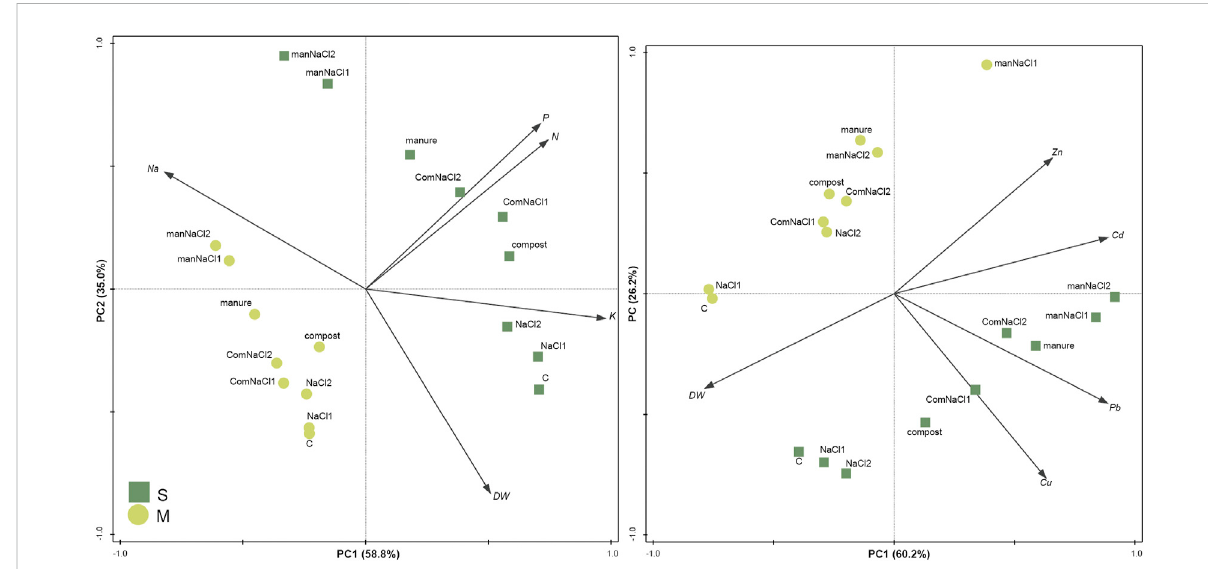
FIGURE 5 Analysis of principal component analysis (PCA). Each data point represents an individual treatment. The quadrangular shape represents several treatments, and round shape represents platn species. Abbreviations: M, alfalfa; S, sorghum. Individual parameters included in the PCA were growth (DW), nitrogen content (N),phosphorus content (P), potassium content (K), sodium content (Na), zinc (Zn), copper (Cu), lead (Pb)and cadmium (Cd). Arrows presents the loading of the individual parameter to PC1 and PC2. Exact loading values are given underneath the abbreviations of individual parameters (left — PC1 loading, right — PC2 loading). The cluster of several treatments in a perticlualr plot indicate strong positive